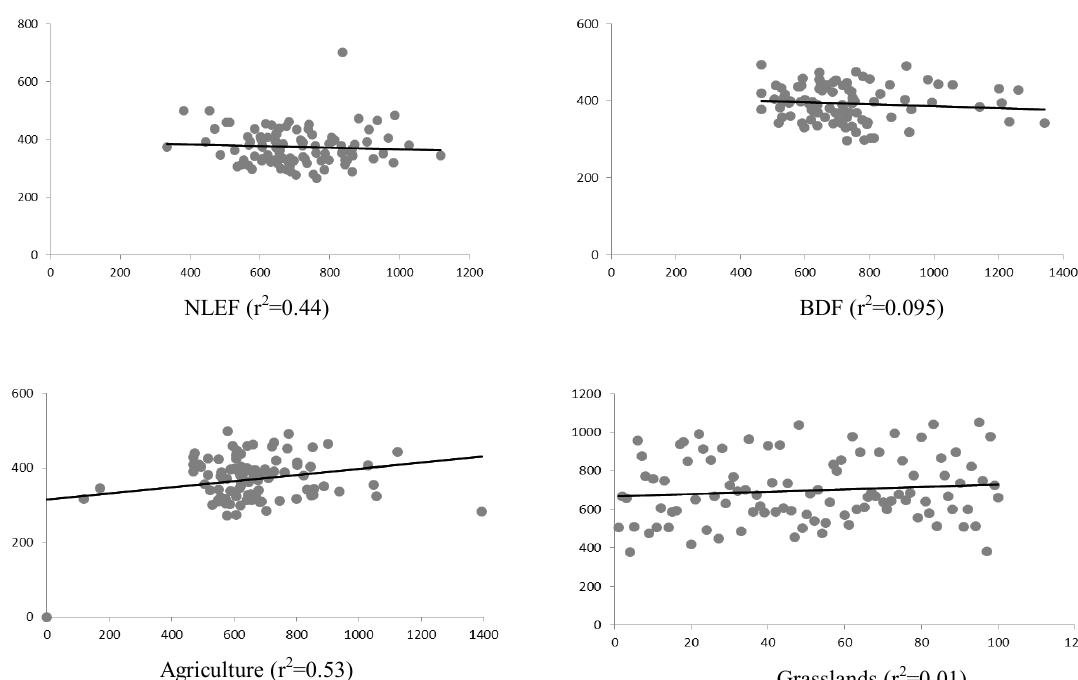
Figure 9. Relationship between CASA and LPJ-GUESS NPP estimations for each land covers